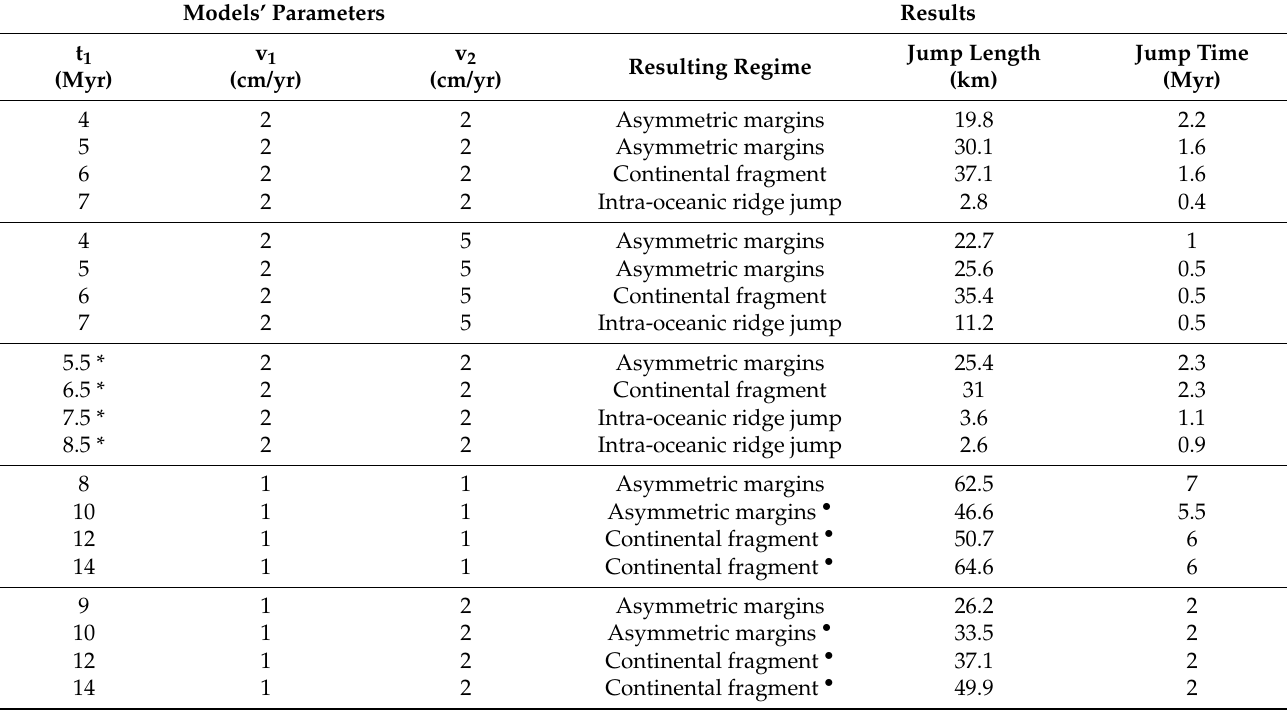
Figure 8. Plots showing the range of values for ( a ) length and ( b ) time of the rift/ridge jumps in all models as a function of their resulting scenarios. Jump time is computed from the moment extension phase 2 starts. Colours show the different extension velocities.